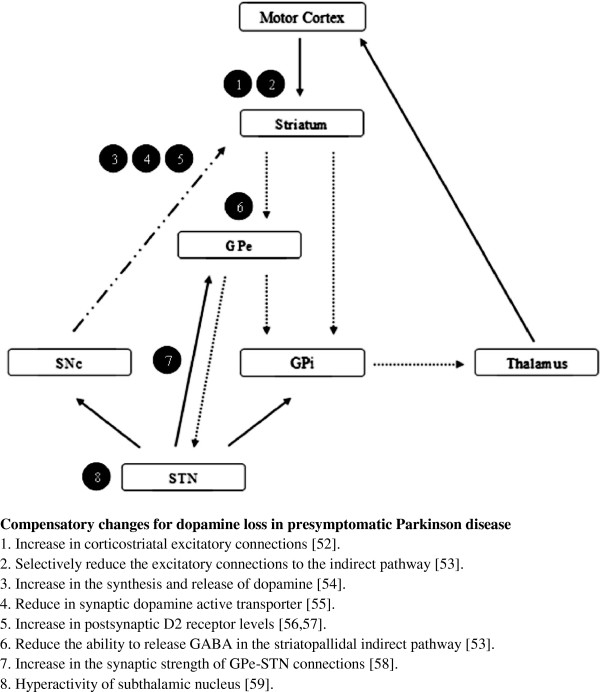
Compensatory changes for dopamine loss in pre-symptomatic Parkinson's disease. Abbreviations: GPe, globus pallidus pars externa; GPi, globus pallidus pars interna; STN, subthalamic nucleus; SNc, substantia nigra pars compacta; GABA, gamma-aminobutyric acid. Solid arrows: excitatory glutamatergic connections; Dot arrows: inhibitory GABAergic connections; Dash dot arrow: dopaminergic connections.